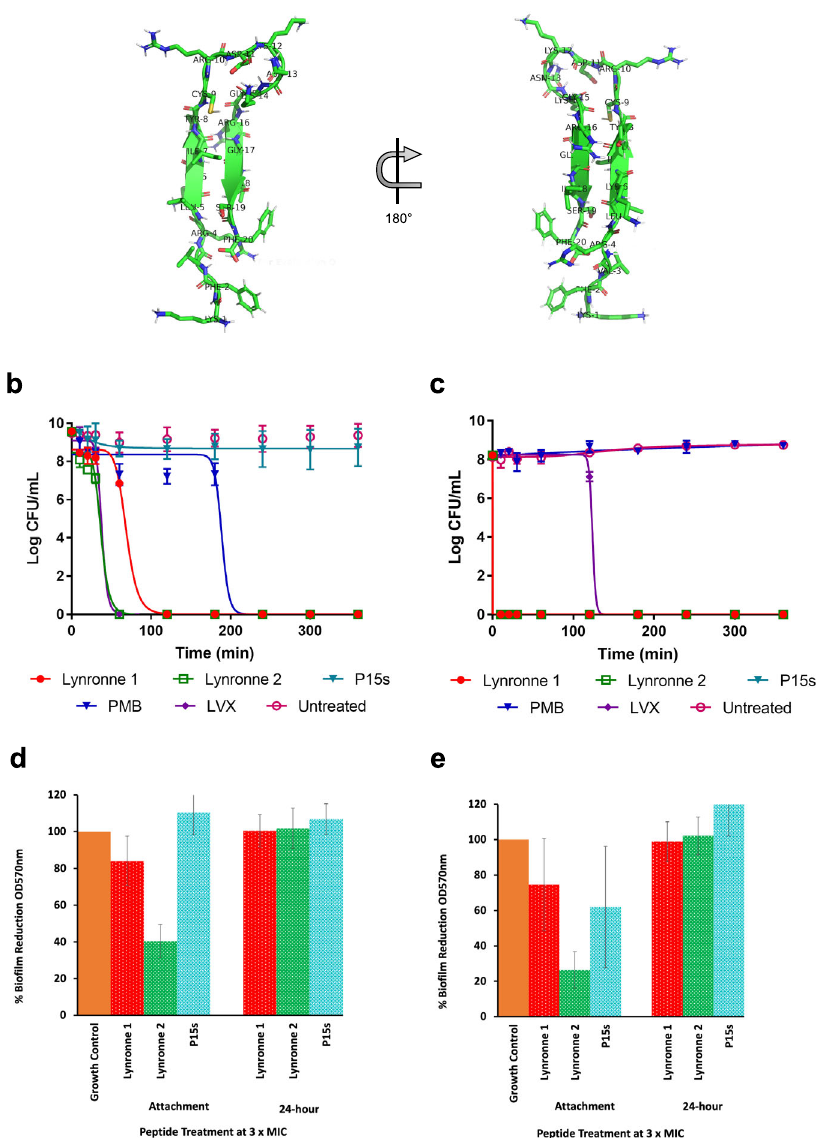
Fig. 1 Predicted 3D structure of P15s, antimicrobial susceptibility and activity of Lynronne 1, 2 and P15s. a Predicted structure for peptide 15s: main-chain and side chains depicted in ribbon and stick representation, respectively, and coloured according to atom type: carbon, oxygen and nitrogen in green, red and blue, respectively. Figure rendered using PyMol. b Time-dependent kill of P. aeruginosa strains PAO1 and ( c ) LES431 by AMPs Lynronne 1, 2 and P15s at 3× MIC concentration. d AMP anti-bio fi lm establishment activity and ef fi cacy against 24 h established bio fi lms of Pseudomonas strain PAO1 and ( e ) LES431 with Lynronne 1, Lynronne 2, and P15s shown as percentage bio fi lm reduction (OD 570nm ) from untreated (growth control), signi fi cance calculated using single-factor ANOVA. For panels b – e , values are from three independent replicates and error bars represent standard deviation (when not visible, this is due to lack of